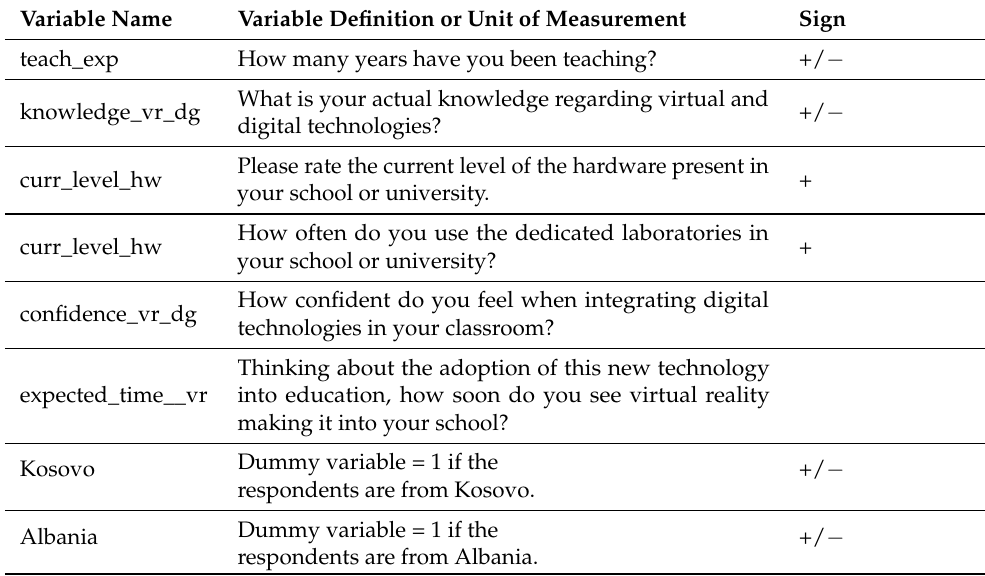
Table 1. Descriptions of the variables employed in the model.